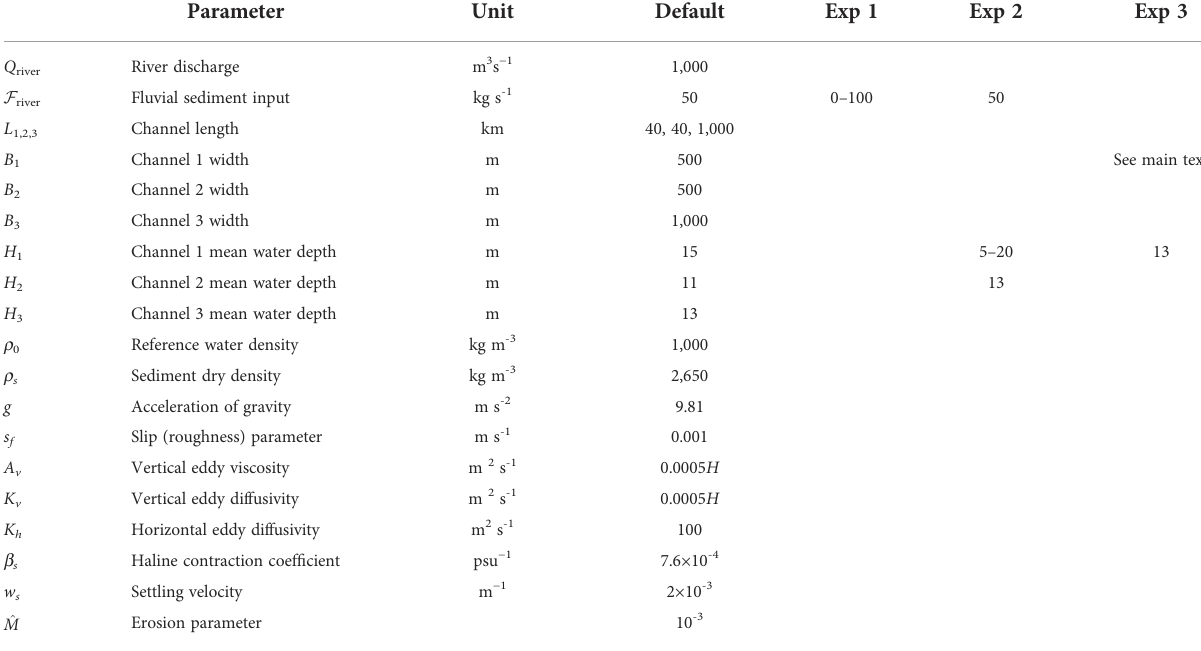
TABLE 1 Parameter values (representative for a coastal plain estuarine